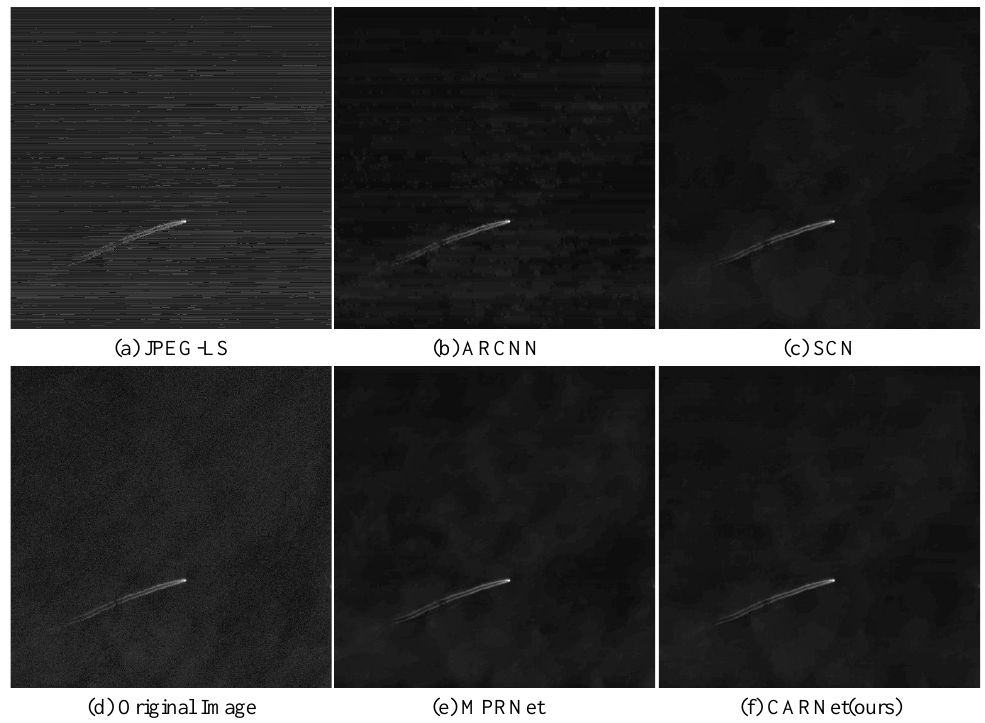
Figure 10. Visual comparison with state-of-the-art methods on a test 10-bit image patch (NEAR = 8).